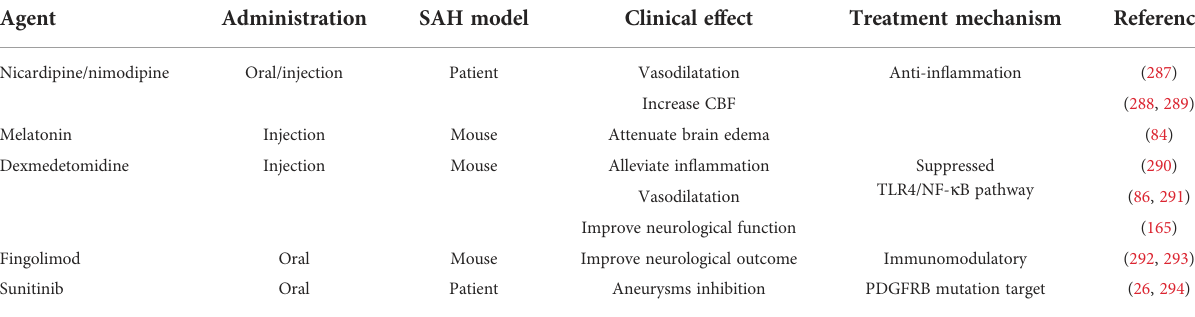
TABLE 2 Therapy strategies in aneurysm